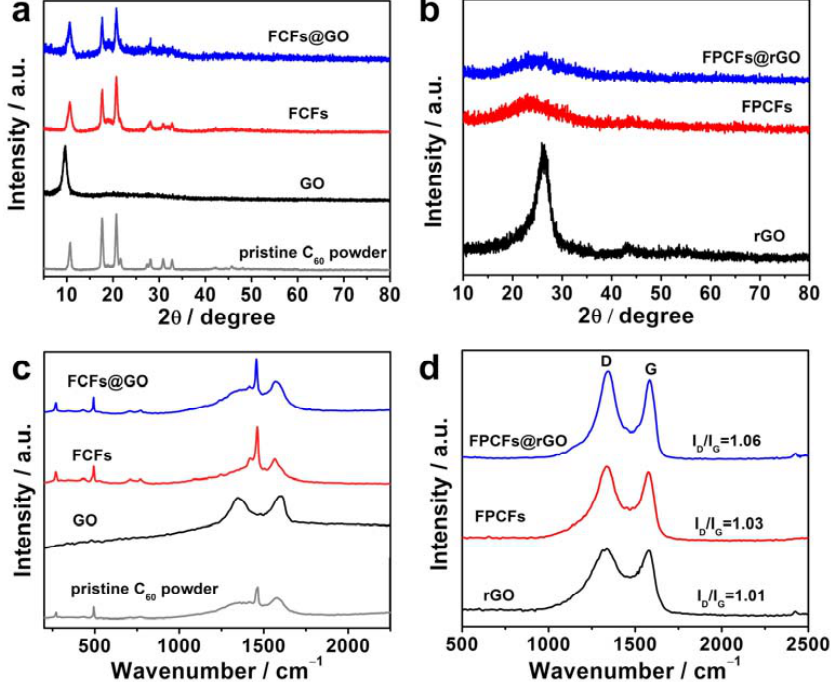
Figure 3. ( a ) XRD patterns and ( c ) Raman spectra of pristine C60 powder, GO, FCFs, and FCFs@GO. ( b ) XRD patterns and ( d ) Raman spectra of rGO, FPCFs, and FPCFs@rGO.